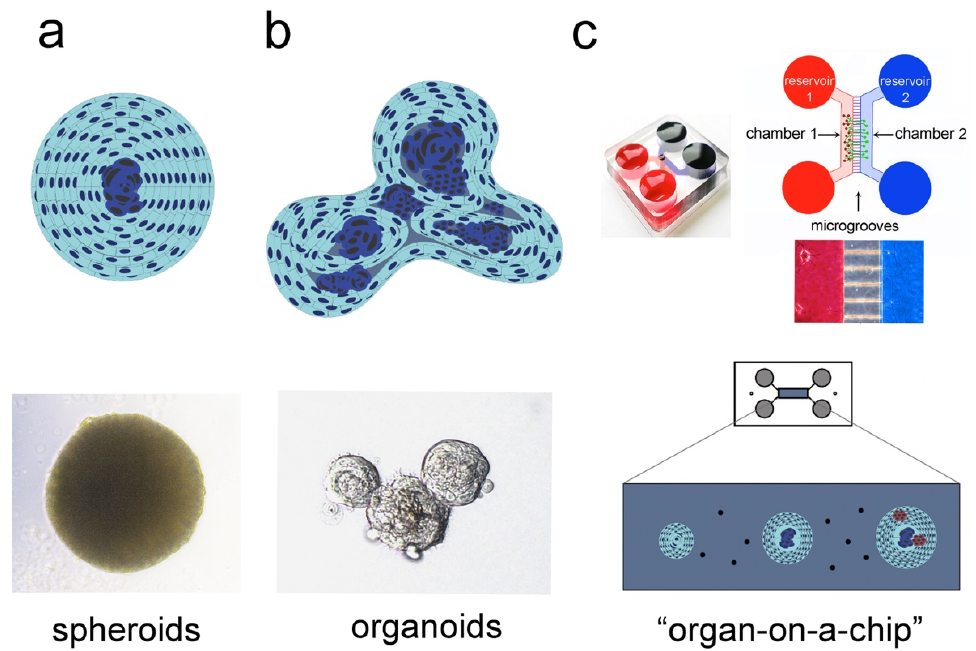
Figure 2. 3D culture systems used to recapitulate the in vivo tissue organisation and complexity. Simplified overview of three different culture models: spheroids ( a ), organoids ( b ), and “organ-on- a-chip” ( c ). ( a ) Spheroids represent the simplest 3D culture system. Spheroids constitute efficient model systems for studying cell–cell communication, cellular metabolism, oxygen gradients, and nutrients distribution. Their complexity can be scaled up by integrating into the spheroids different cell types, such as stem cells and endothelial cells, thus providing the ideal platform for biochemical and molecular testing, as well as rapid drug screening. ( b ) Organoids reproduce the complexity of the native tissue, where cells at various cytodifferentiation states, ranging from stem cells and progenitors to fully differentiated cells, coexist. ( c ) “Organ-on-a-chip” closely mimics several aspects of the native organ. Integrated into a microfluidic system, 2D cultures, spheroids and organoids can be exposed to a dynamic microenvironment that allows controlled fluid exchange and interactions between different tissues, such as vessels and nerves (adapted from